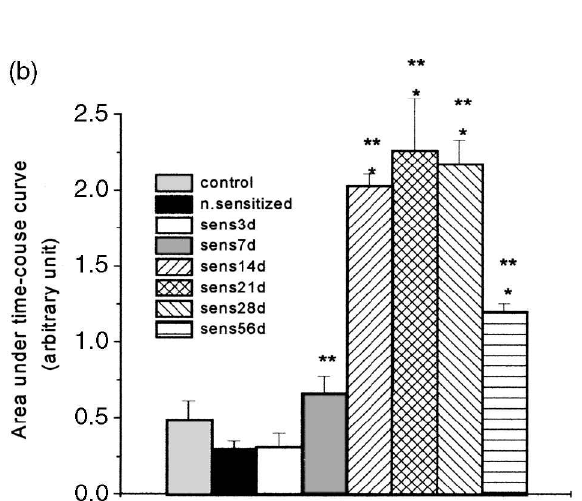
FIG. 1. Dose-dependence course of sensitization of rats prior induction of ovalbumin (ova) – paw oedema. (a) Rats were sham-sensitized with Al(OH) 3 (control) or pre-sensitized with ova at the doses indicated ( m g/rat) and 14–18 days after challenge were intraplantar injected (10 m g/paw). Oedema was evaluated 1, 2, 3 and 4h after challenge. (b) The area under the time-course curve was determined using a trape- zoidal rule. Each point represents the mean ± SEM for the number of animals indicated. *Significant differences com- pared with the sham-sensitized (control) ( p < 0.05; ANOVA, Student’s t -test).